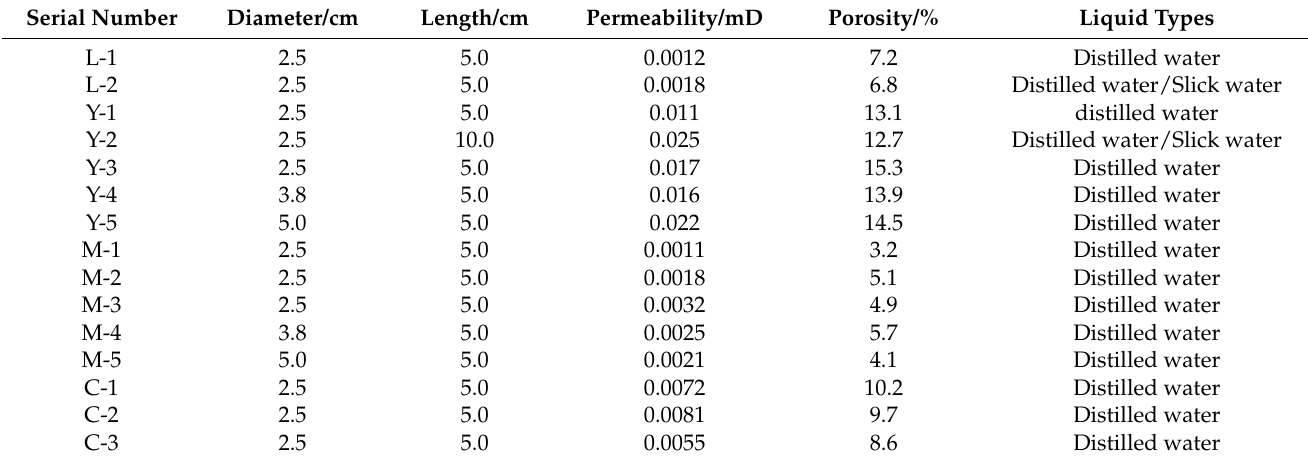
Table 3. Fundamental parameters of samples and liquid